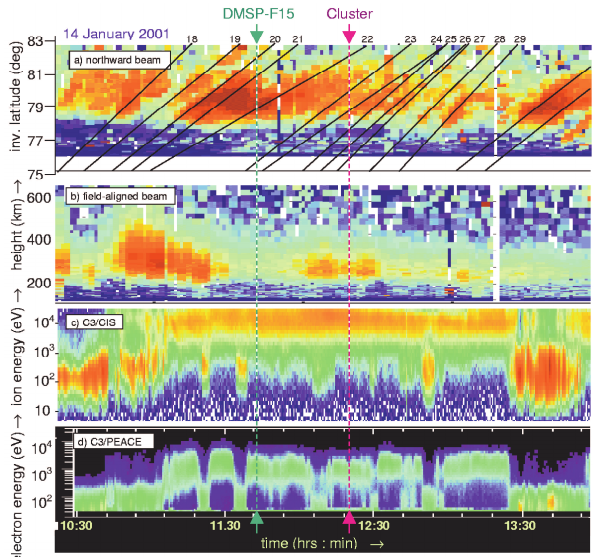
Fig. 7. The transient events seen by Cluster and the EISCAT Sval- bard Radar on 14 January 2001. From the top: (a) electron den- sity observed along the northward-looking beam of the ESR, with black lines marking poleward moving events, (b) electron density observed along the field-aligned ESR beam, (c) energy-time spec- trogram of ion differential flux as observed by the CIS instrument on Cluster 3 and (d) energy-time spectrogram of electron count rate observed by the HEEA detector of the PEACE instrument on Clus- ter 3. The numbering scheme for events in the top panel corresponds to that in Fig. 6. The mauve and green arrows represent the times of closest conjunction of the ESR with Cluster and DMSP-F15, re- spectively. (From Lockwood et al.,